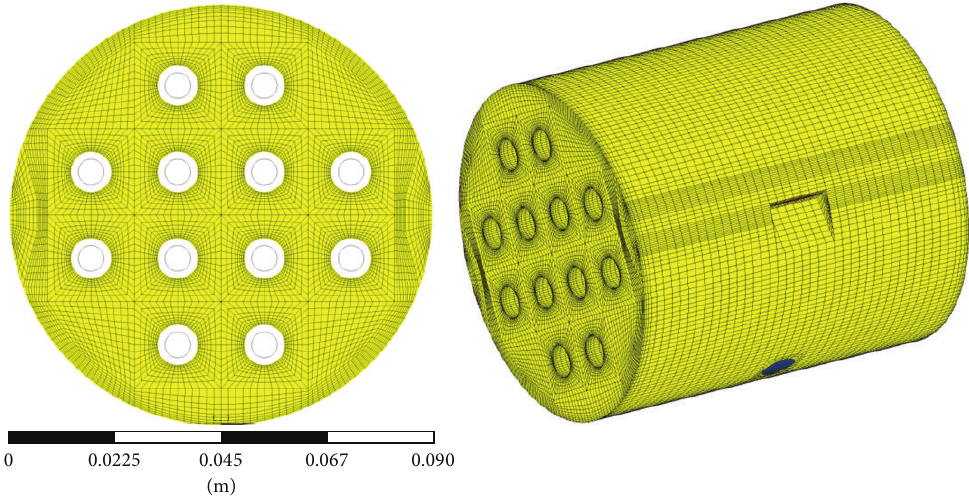
Figure 4: Mesh generation for 1/40 scaled-down